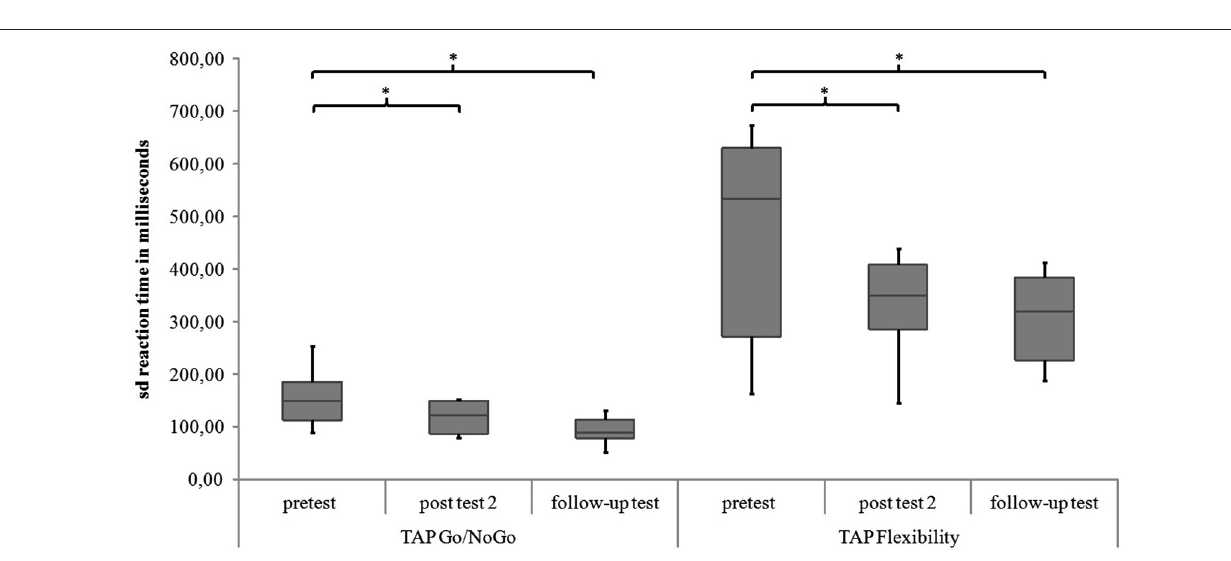
symptoms in the FBB-ADHS and in the teachers’ rating of associated behavioral symptoms in the SDQ (see Table 4